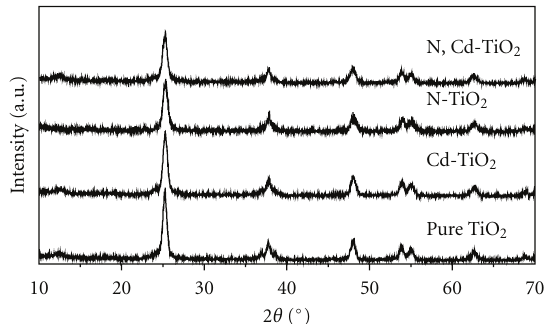
Figure 2: SEM images of N, Cd-codoped TiO 2 calcined at 450 ◦ C.